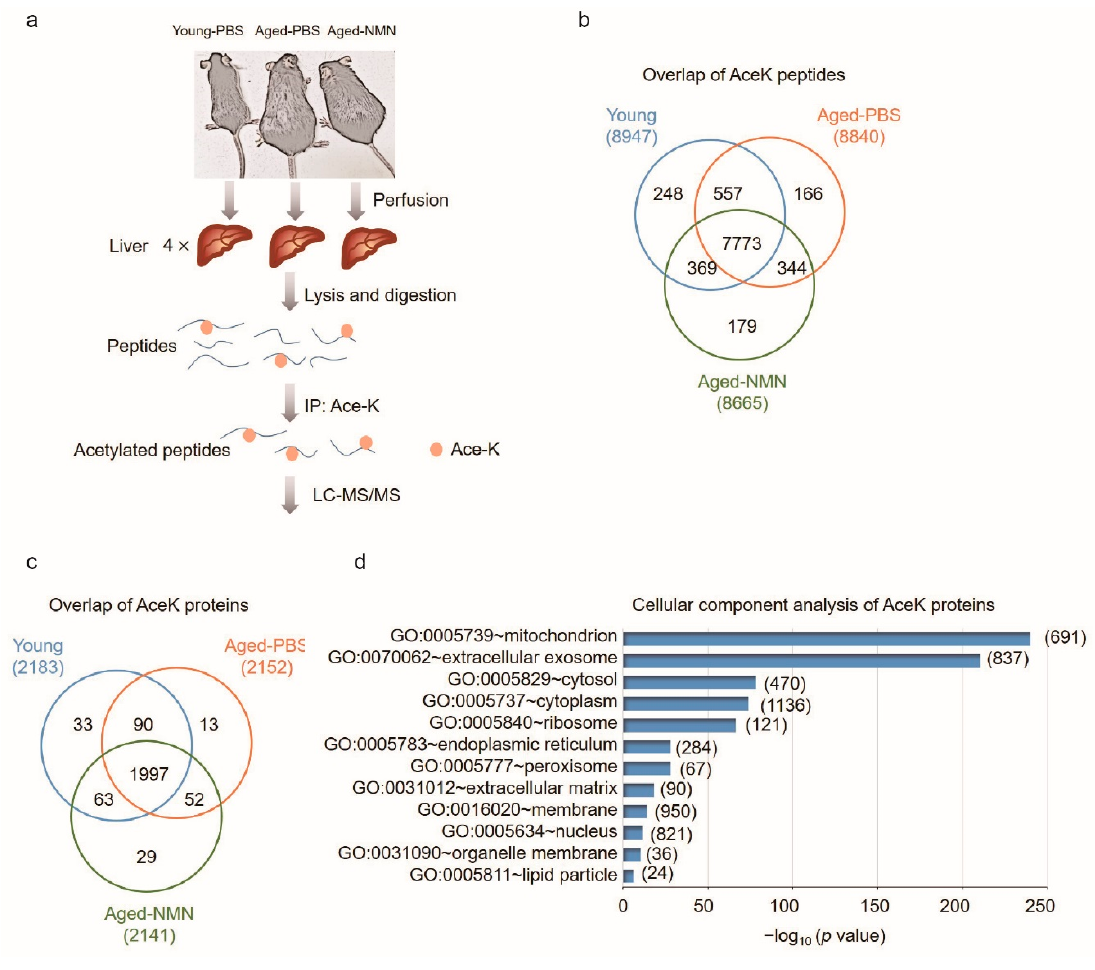
Figure 2. Identification of liver acetylome from young, untreated and NMN-treated aged mice. ( a ) A graphical illustration of liver acetylomic analysis using immunoprecipitation coupled with label-free quantitative LC-MS/MS (IPMS). ( b ) Numbers of acetylated peptides identified from young, aged-PBS and aged-NMN mouse liver. ( c ) Numbers of acetylated proteins identified from young, aged-PBS and aged-NMN mouse liver. ( d ) Cellular component analysis of the acetylated proteins that commonly identified from young, aged-PBS and aged-NMN mouse liver samples. Young-PBS: young mice treated with PBS, Aged-PBS: aged mice treated with PBS, Aged-NMN: aged mice treated with NMN.